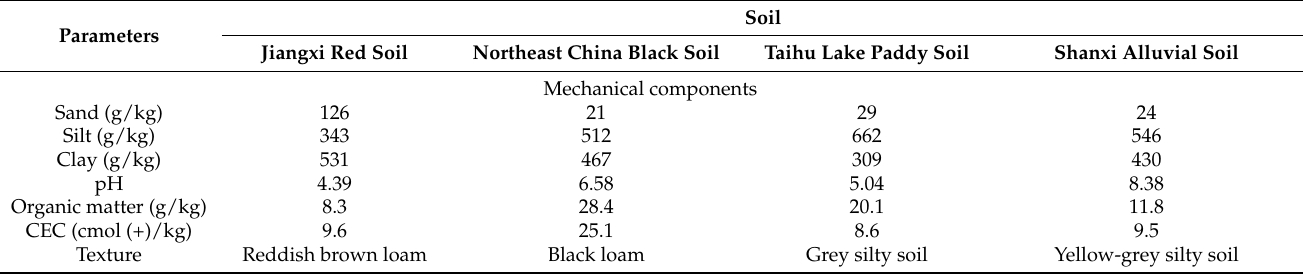
Table 1. The basic physicochemical properties of